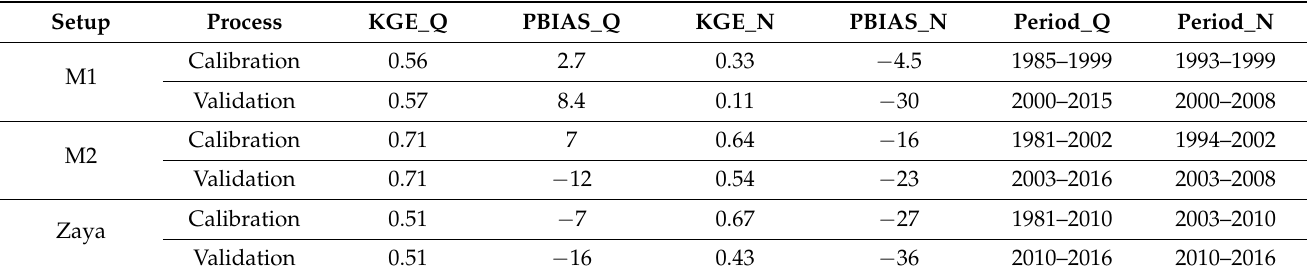
Table 4. Model performance for the daily calibration and validation for discharge (Q) and NO 3 − -N concentration